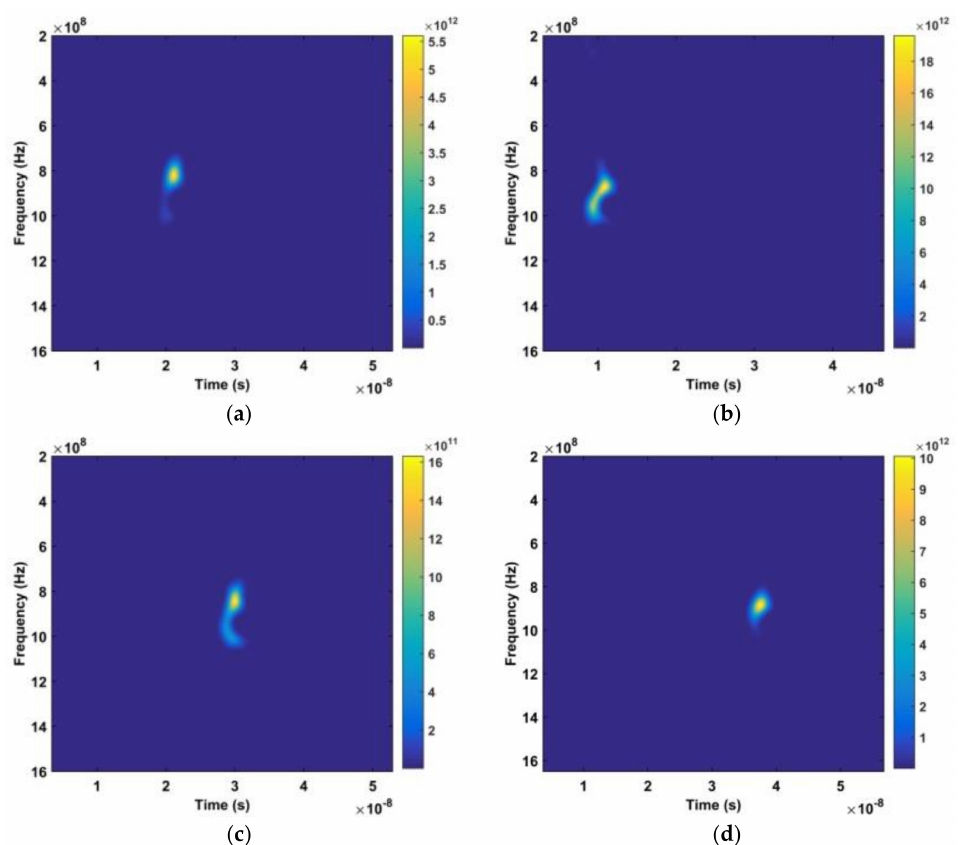
Figure 7. The time-frequency matrices obtained using the DWFT. The distances between the antenna and subject are ( a ) 300 cm, ( b ) 600 cm, ( c ) 900 cm, and ( d ) 1100 cm. To obtain the range of the subject from K O × P , a frequency window of width 0.6 to 1.2 GHz is employed. If ˆ τ corresponds to the maximum amplitude index, then the estimated range is ˆ τ L = v × 2